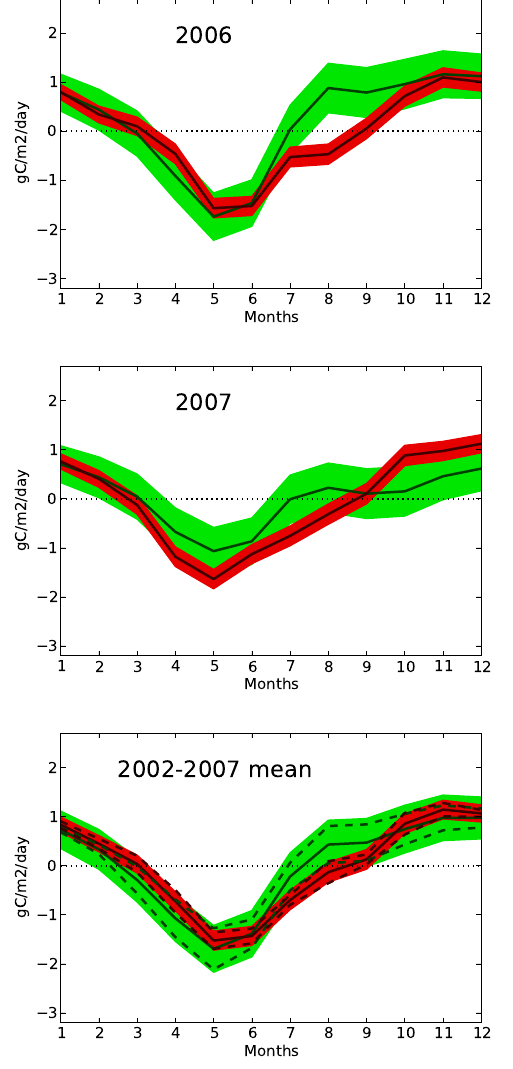
Fig. 5. Annual (i.e. 360-day mean) NEE anomalies to the 2002–2007 mean ( gCm − 2 year − 1 ; negative values: sink) at the CE-L4 locations specified in the maps of Fig. 2 and for the whole European domain.